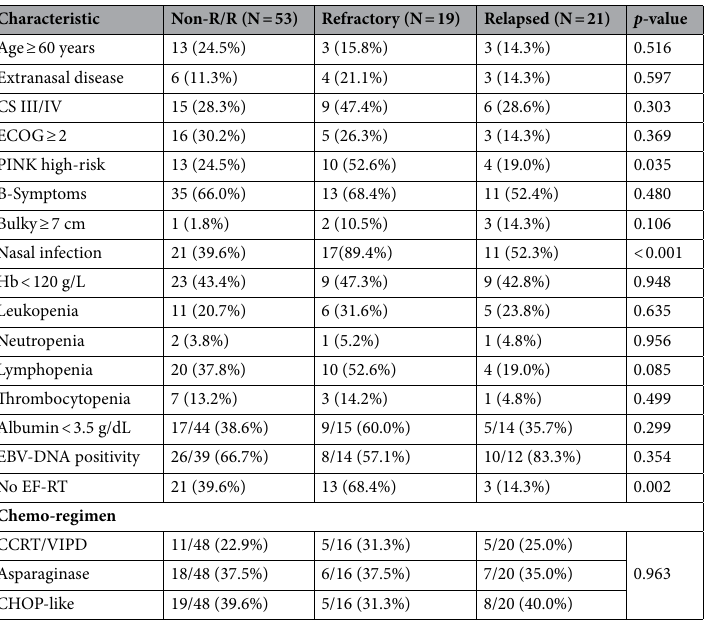
Table 2. Clinical-laboratory characteristics and therapeutic modalities in 93 ENKTL patients categorized by response to up-front treatment. R/R Relapsed/refractory disease, CS Clinical stage (Ann Arbor/ Cotswolds), ECOG Eastern Cooperative Oncology Group scale, PINK Prognostic index for nasal NK lymphoma, LDH Lactic dehydrogenase, Hb Hemoglobin, Leukopenia < 4.0 × 10 9 /L, Neutropenia < 1.5 × 10 9 / L, Lymphopenia < 0.9 × 10 9 /L, Thrombocytopenia < 150 × 10 9 /L, EBV DNA Epstein-Barr virus DNA by qualitative PCR in peripheral blood sample, EF-RT Extended-field radiotherapy, CCRT/VIPD Concurrent chemoradiotherapy/etoposide, ifosfamide, cisplatin and dexamethasone, CHOP Cyclophosphamide, doxorubicin, vincristine and